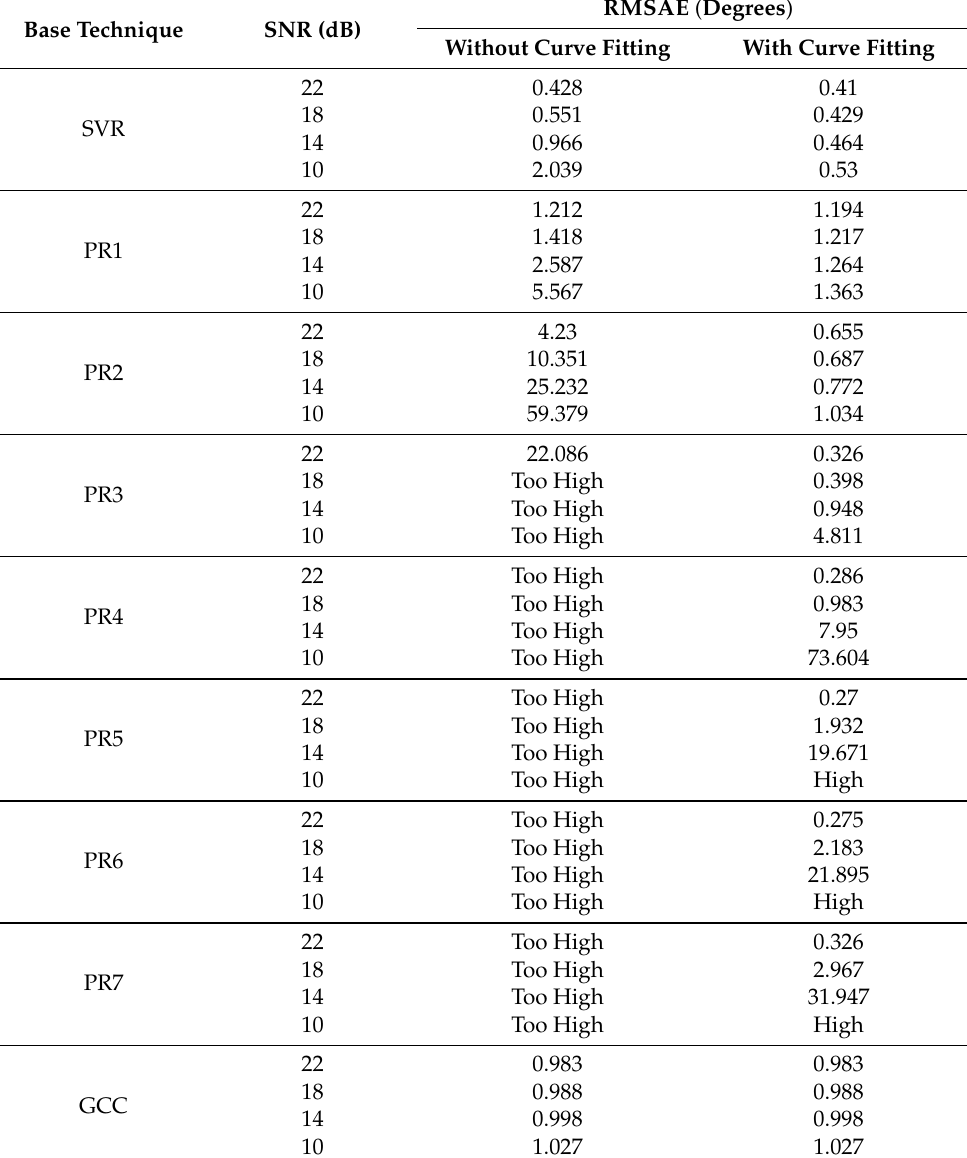
Table 1. RMSAE (degrees) values with multiple regressions and conventional